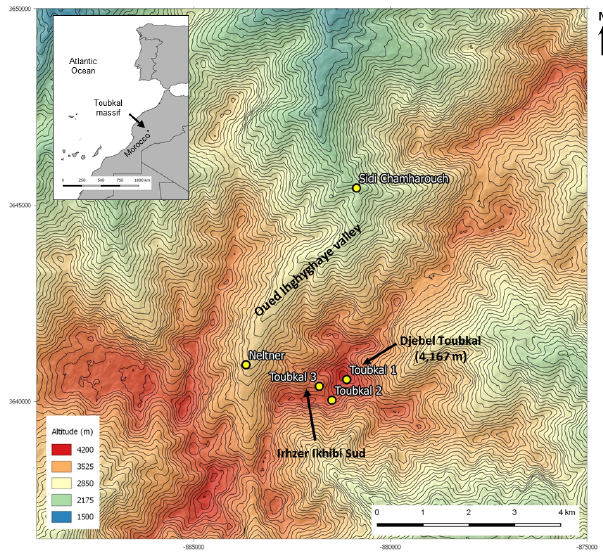
Figure 1. Location and topography of the Toubkal massif study area. Yellow circles are the locations of the data loggers. Contour equidistance is